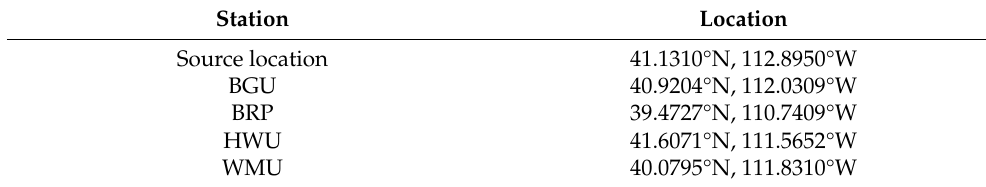
Table 1. UTTR source location and observations (See also in Figure13).